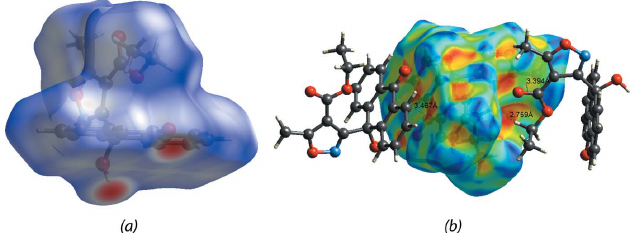
Figure 8 ( a ) The Hirshfeld surface of (V) mapped over d norm . Short and long contacts are indicated as red and blue spots, respectively. Contacts with distances approximately equal to the sum of the van der Waals radii are colored white. Hydroxyl and carbonyl groups on the anthrone ring contributed major short contacts. ( b ) (cid:3) – (cid:3) interactions (anthrone to anthrone and carbonyl to isoxazole ring) and (cid:4) – (cid:3) interaction (C—H bond to carbonyl) are shown as orange–red spots with green dashed lines in the shape-index map.